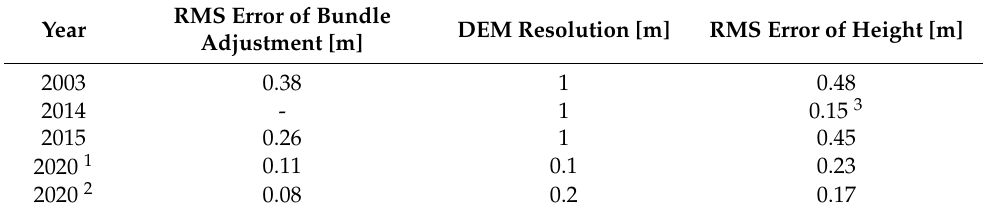
Table 2. Accuracy of DEM used for